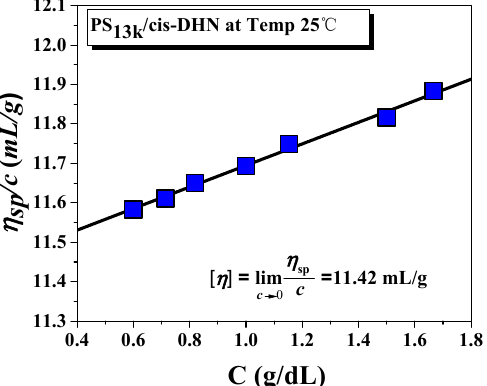
Figure 4. The reduced viscosity η sp / c as a function of concentration for PS (with M n = 13,000 Da) in DHN at 25 °C.